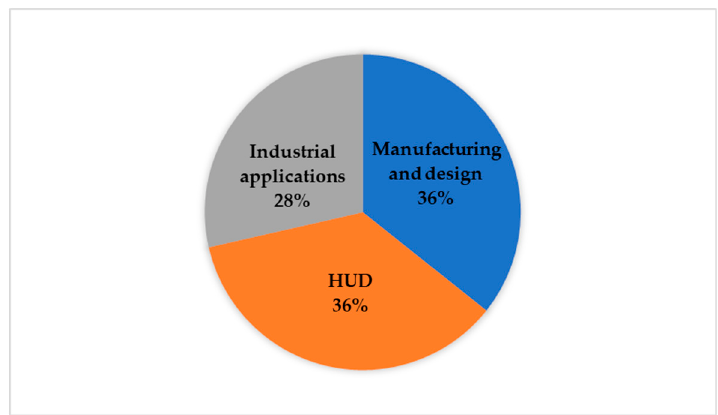
Figure 8. Distribution of review articles per field.